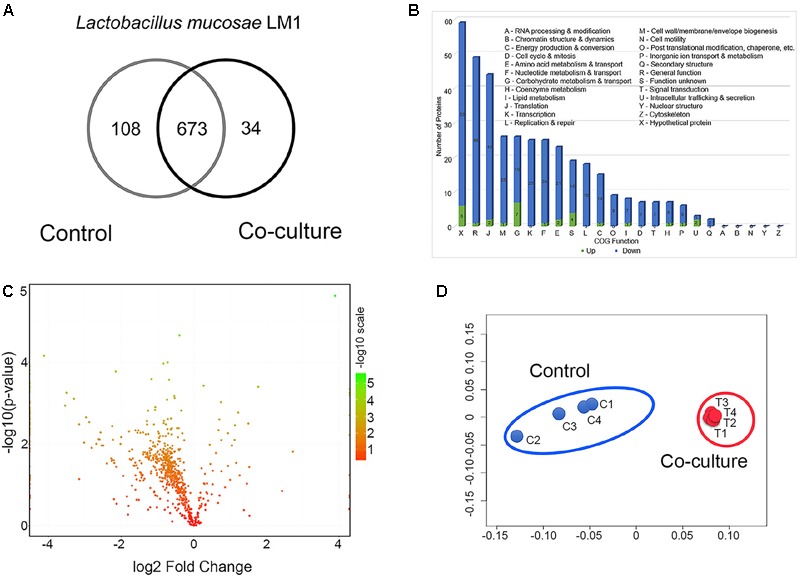
Global proteome profile and differentially expressed proteins (DEPs) from LM1 in co-culture conditions. (A) Venn diagram of unique and shared proteins detected from LM1. (B) Functional classification of LM1 proteins using Cluster of Orthologous Groups (COG). The numbers of downregulated (blue) and upregulated (green) proteins are indicated. (C) A volcano plot of the deactivated/downregulated (left, 348) and activated/upregulated (right, 28) proteins. P-values were calculated and plotted on the y-axis as –log10(p-value). Values for y-axis [–log10(p-value)] above 1.3 were considered significant. (D) Non-metric multidimensional scaling (NMDS) plot of individual LM1 proteomes showing distinct clustering of each group. Individual proteomes are separated in control (C1–C4) and co-culture (T1–T4).